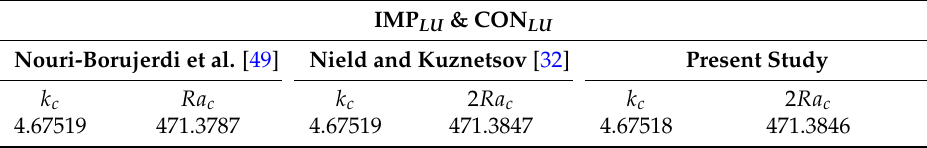
Table 1. Comparison of critical Rayleigh number Ra c and the critical wave number k c for IMP LU & CON LU boundary